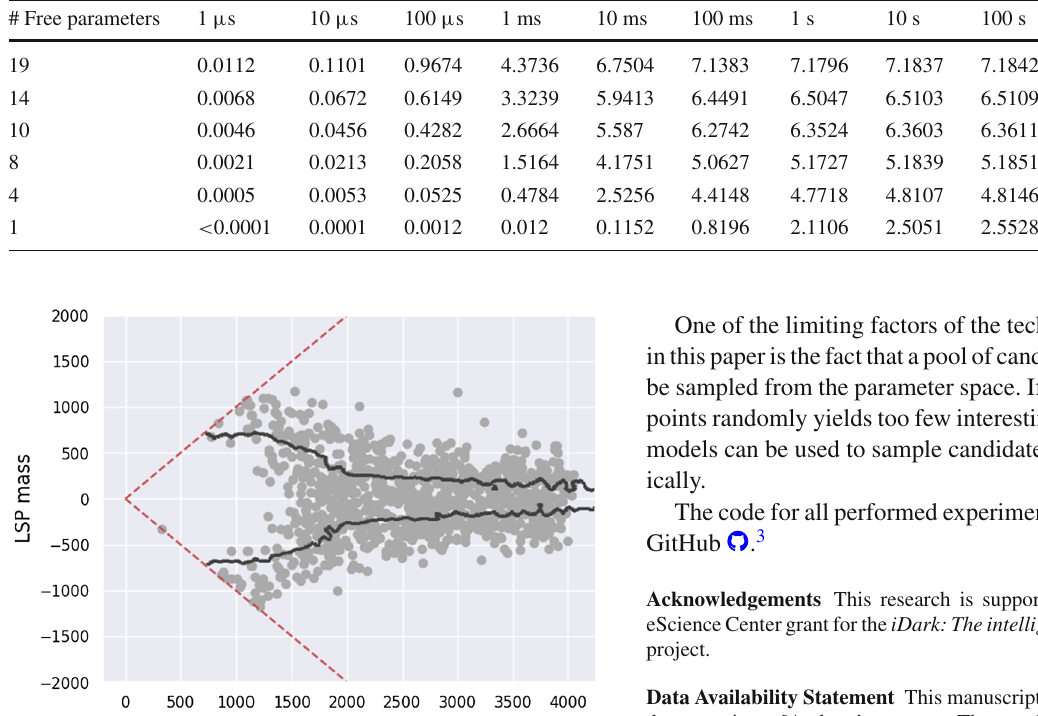
Table 2 Relative time gain (Eq. 4) of the active learning procedure with respect to random sampling when attempting to obtain the max- imum performance obtained with random sampling. The table shows this gain for different parameter space dimensionalities (rows) and for different costs for querying the oracle (columns). The shown results are the averages over all seven iterations of the experiment in Sect. 3.2.